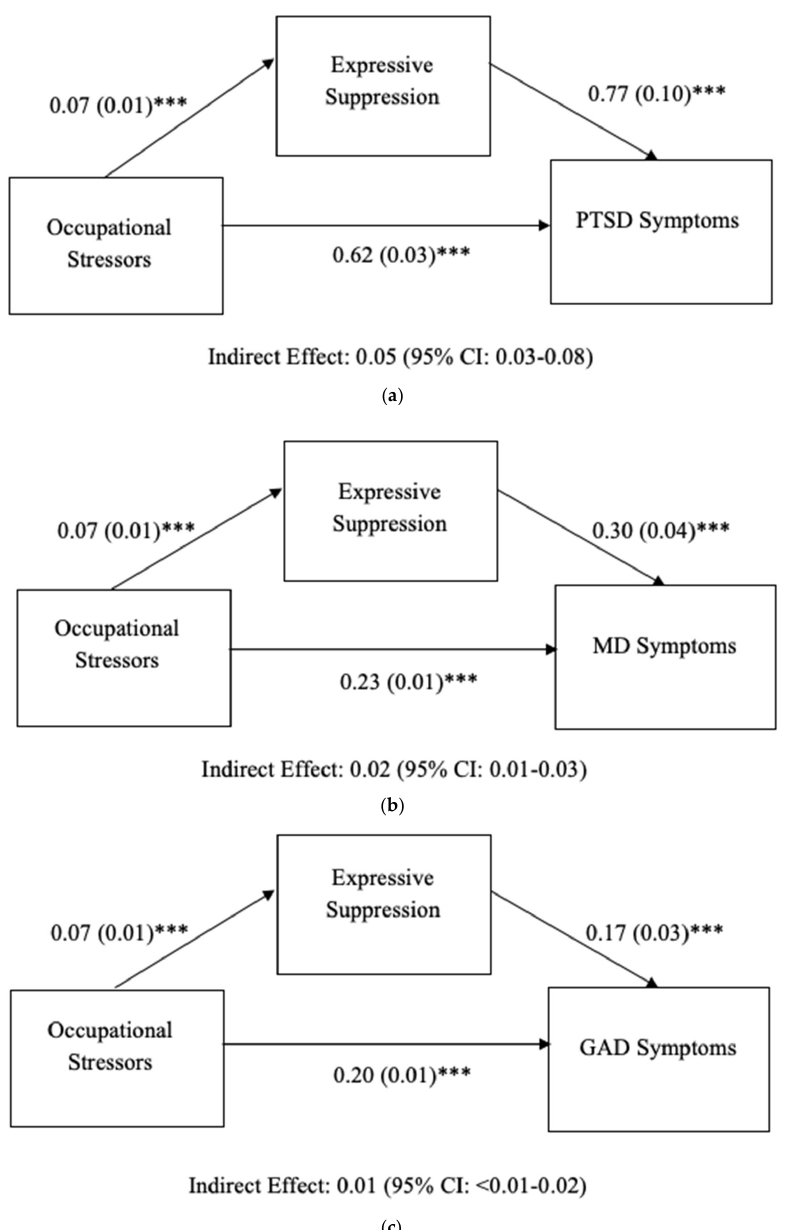
Figure 1. ( a ) Results of mediation model predicting PTSD. Analysis controlled for demographic (age, gender) and work-related (first response type, department, area, employment status, agency) variables. Occupational Stressors, Expressive Suppression, PTSD: Posttraumatic Stress Disorder. ( b ) Results of mediation model predicting MD. Analysis controlled for demographic (age, gender) and work-related (first response type, department, area, employment status, agency) variables. Occupa- tional Stressors, Expressive Suppression, MD = Major Depression. ( c ) Results of mediation model predicting GAD. Analysis controlled for demographic (age, gender) and work-related (first re- sponse type, department, area, employment status, agency) variables. Occupational Stressors, Ex- pressive Suppression, GAD: Generalized Anxiety Disorder. Unstandardized regression coefficients ( B ) are listed. *** p < 0.001.